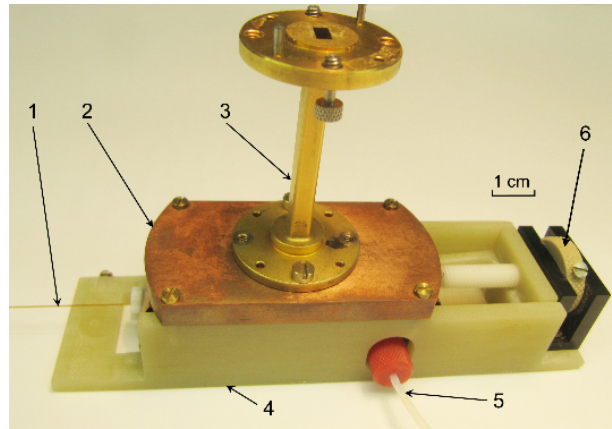
Figure 7. The resonator assembly. 1 – quartz capillary from the resonator to phantom, 2 – concave mirror, 3 – WR-22 waveguide, 4 – housing including the plain mirror, 5 – 0.8mm ID tubing from the syringe filled with the TEMPOL solution, 6 – frequency tune knob.